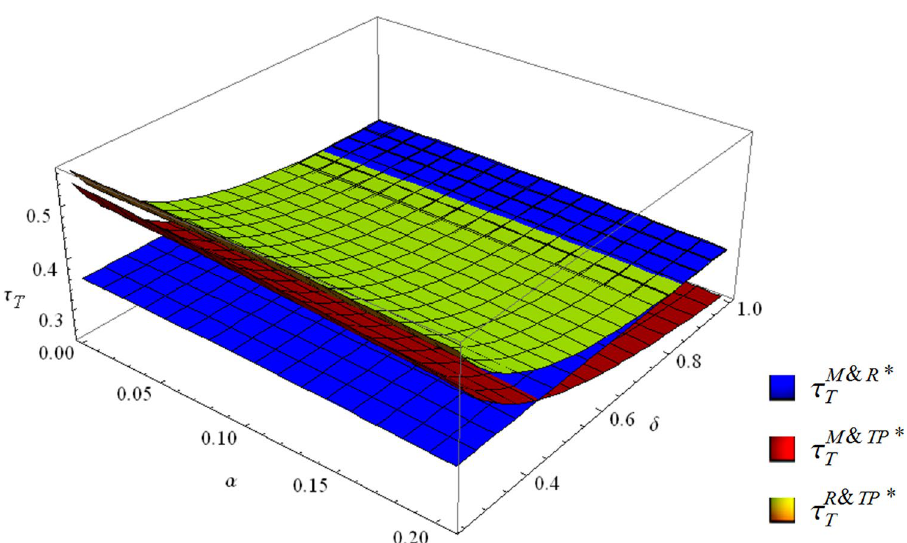
Figure 5. The total collection rates of the three collection